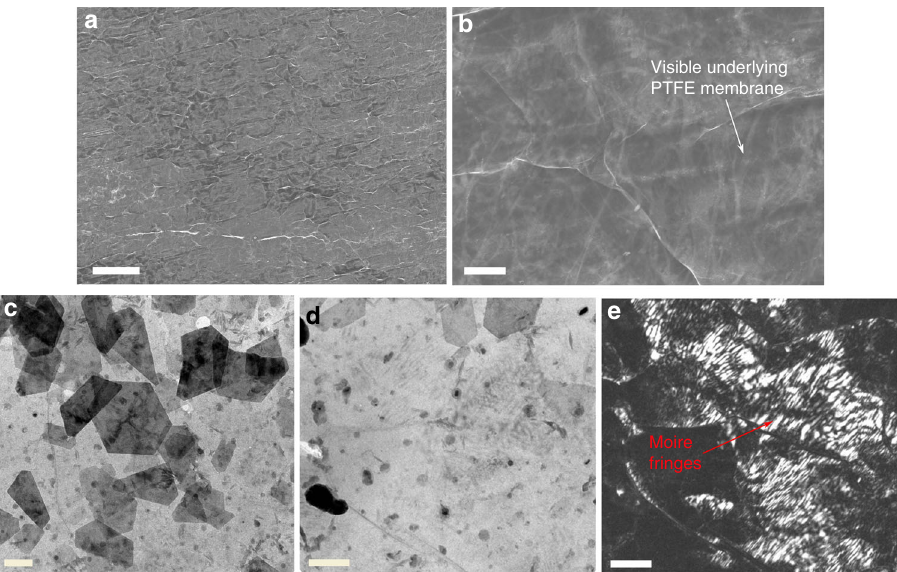
Fig. 2 Characteristics of permeable graphene fi lms. Several nanoscopic features in permeable graphene fi lm enable water permeation and desalination. The microscopic morphology of the graphene fi lm was investigated using SEM, revealing the graphene fi lm on the PTFE membrane in a low-magni fi cation, scale bar 30 µ m and b high-magni fi cation, scale bar 2 µ m. Many ripples on the surface of the graphene fi lm are observed, and the high transparency of the graphene fi lm allows one to observe the underlying PTFE membrane. TEM images in c low-magni fi cation, and respective d bright- fi eld and e dark- fi eld images show many small graphene domains with many thick dark lines corresponding to the overlapping of grain boundaries that form the channels for the